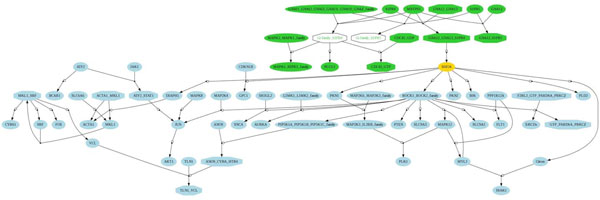
Interaction between S1P4 and RHOA signaling pathways. The pathways are integrated and visualized via the Pathway Integration Tool (PINT) [36]. The oval nodes denote the proteins, and the octagon nodes denote the protein complexes. The edges between nodes represent the interactions or reactions. The green and blue nodes correspond to the components in S1P4 and ROHA signaling pathways, respectively. The yellow node is the common component between pathways.